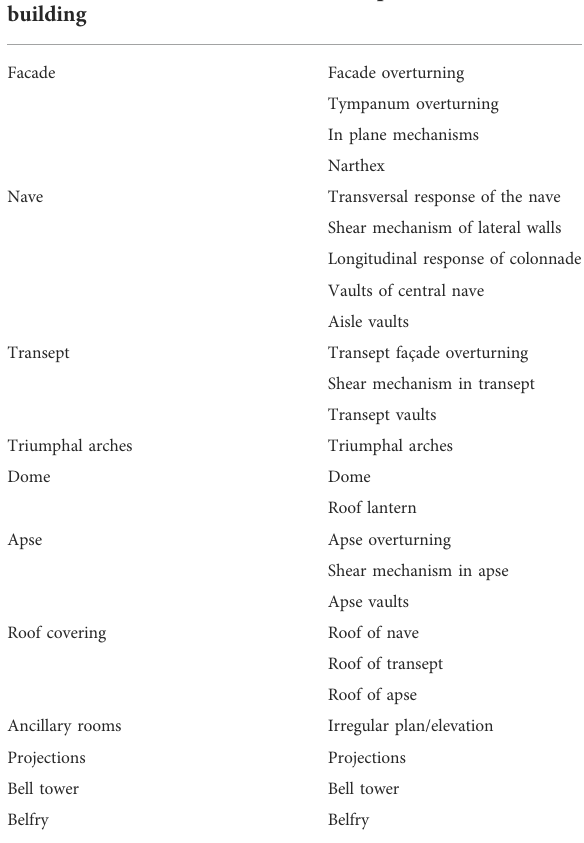
TABLE 1 Possible collapse mechanisms of a typical church building (Lagomarsino et al.,